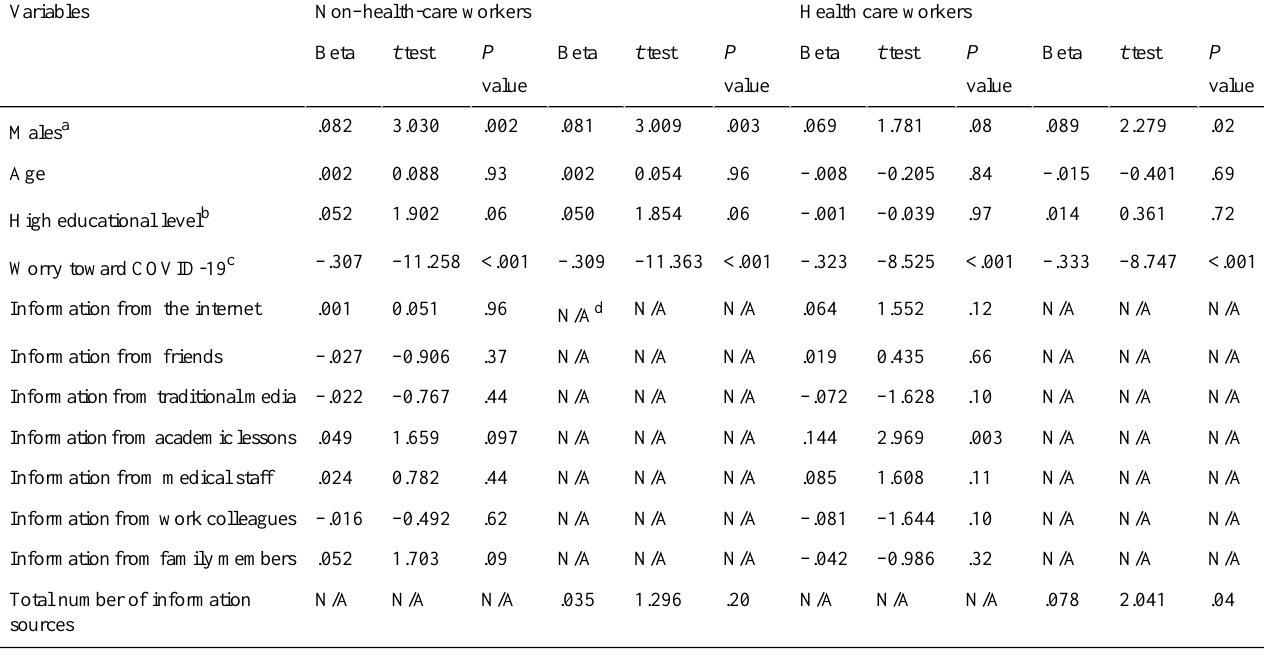
Table 4. Associations of COVID-19 information sources with self-confidence in coping with